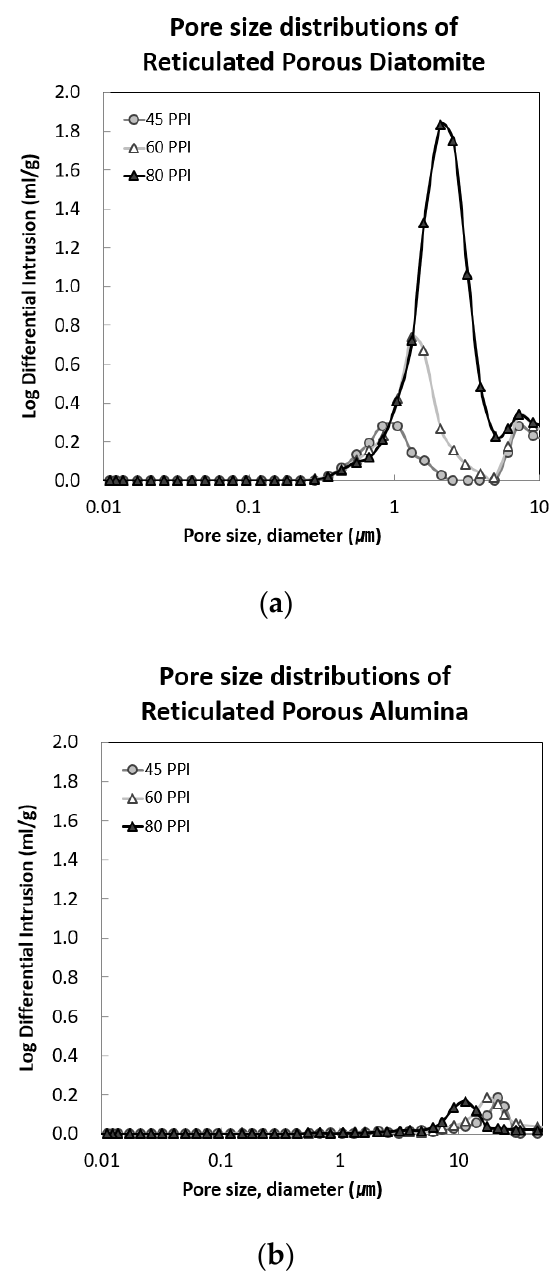
Figure 6. Pore size distributions of ( a ) the reticulated porous diatomite-kaolin composite specimens and ( b ) the reticulated porous alumina specimens, with pore densities of 45, 60, and 80 PPI.